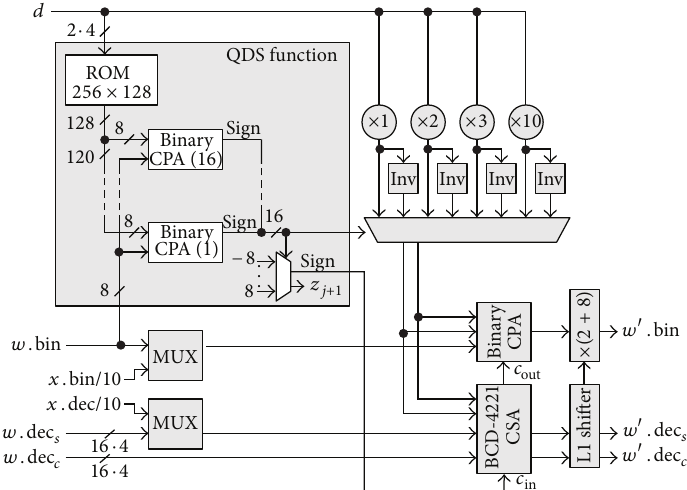
Figure 4: Block diagram of type3 digit recurrence.